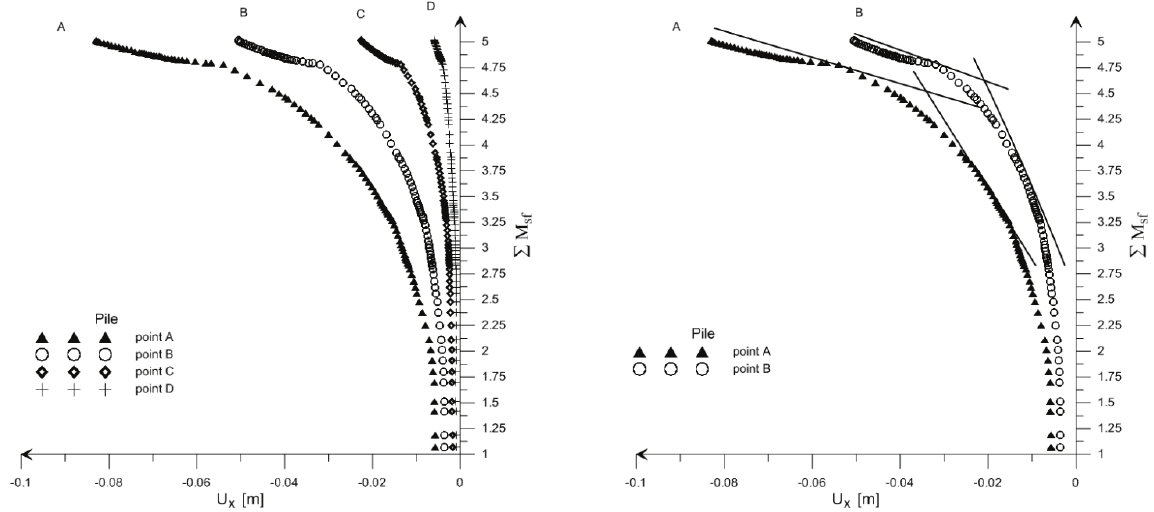
Fig. 14. Determining safety factor for measurement points in a pile (excavation depth 2 m)